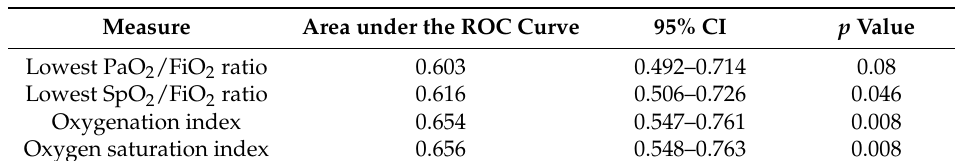
Table 2. Comparison of areas under the receiver-operating characteristic (ROC) curve for discrimination of mortality of ARDS for four indices of oxygenation.